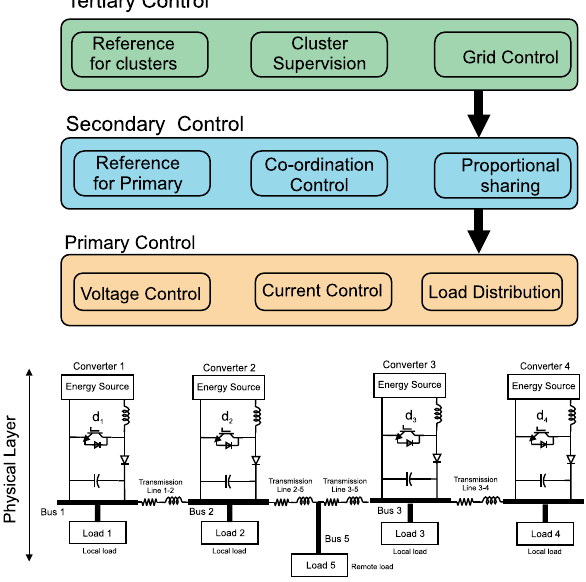
Figure 34. Control hierarchy for